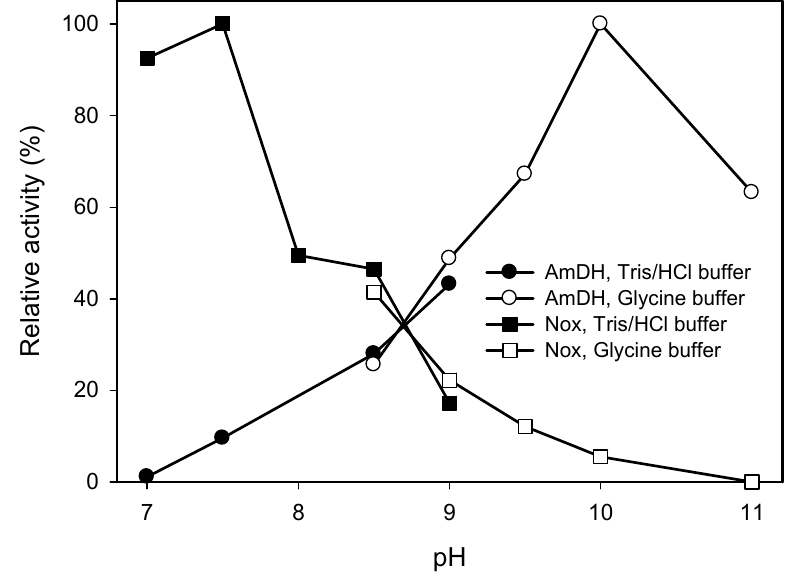
Figure 4. Effect of pH on the activity of AmDH and Nox. For the AmDH activity assay, the reactions were performed in 100 mM Tris/HCl buffer (pH 7.0–9.0) or 100 mM glycine buffer (pH 9.0–11.0) containing 20 mM a1 , 1 mM NAD + , and AmDH (0.15 mg/mL). For the Nox activity assay, 0.2 mM NADH and 0.01 mg/mL of Nox were used.